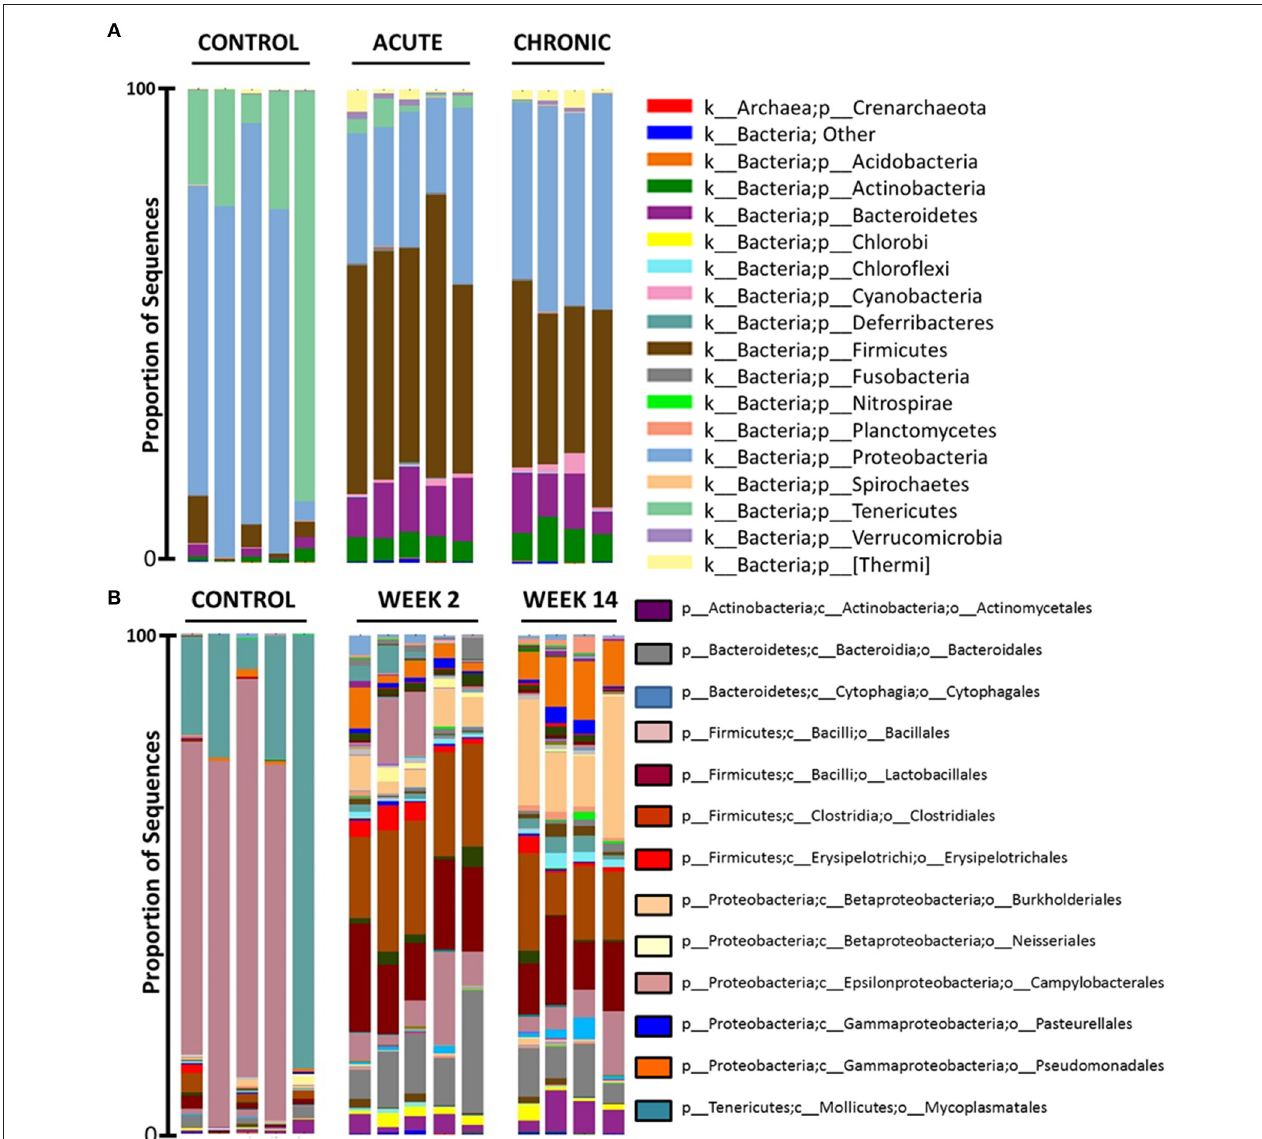
FIGURE 8 | 16s rRNA gene-based bacterial community composition of three groups [Control ( n = 5), Week 2 ( n = 5) and Week 14 ( n = 4)]. Bacterial community sequence data are displayed at phylum (A) and order (B)